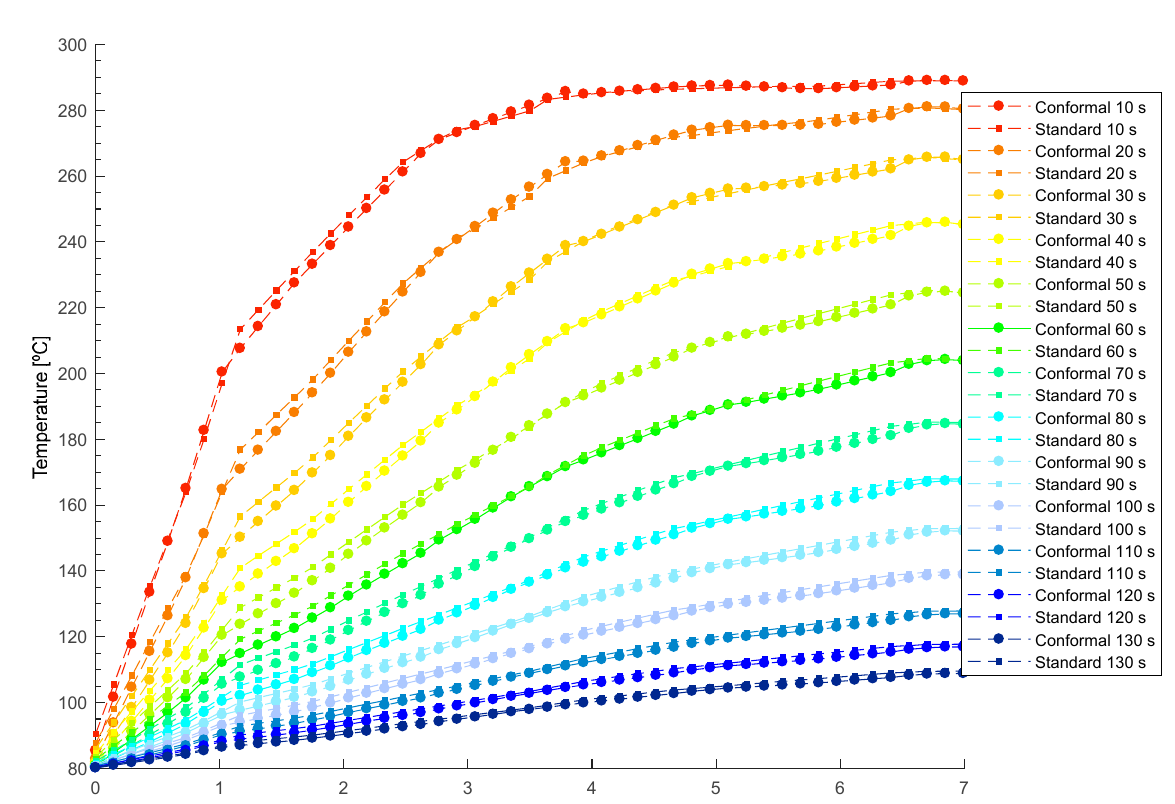
Figure 18. Temperature profile of the plastic part [°C] versus the thickness [mm] resulting in the collimator region during the transient numerical analysis.